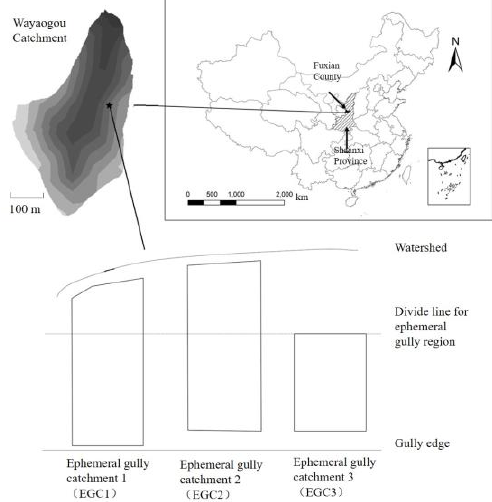
Figure 1 Location map of Wayaogou catchment and ephemeral gully catchments